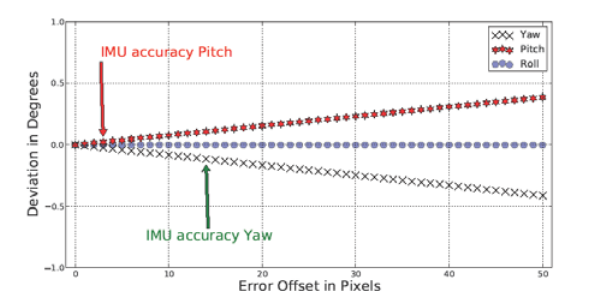
Figure 2. Shift from 1 to 50 pixels have been added to simulated matching points and relative angles were calculated for a typical configuration of Roll=-2°, Pitch=-1.5°, Yaw=3.2°. The deviations of calculated and original angles are